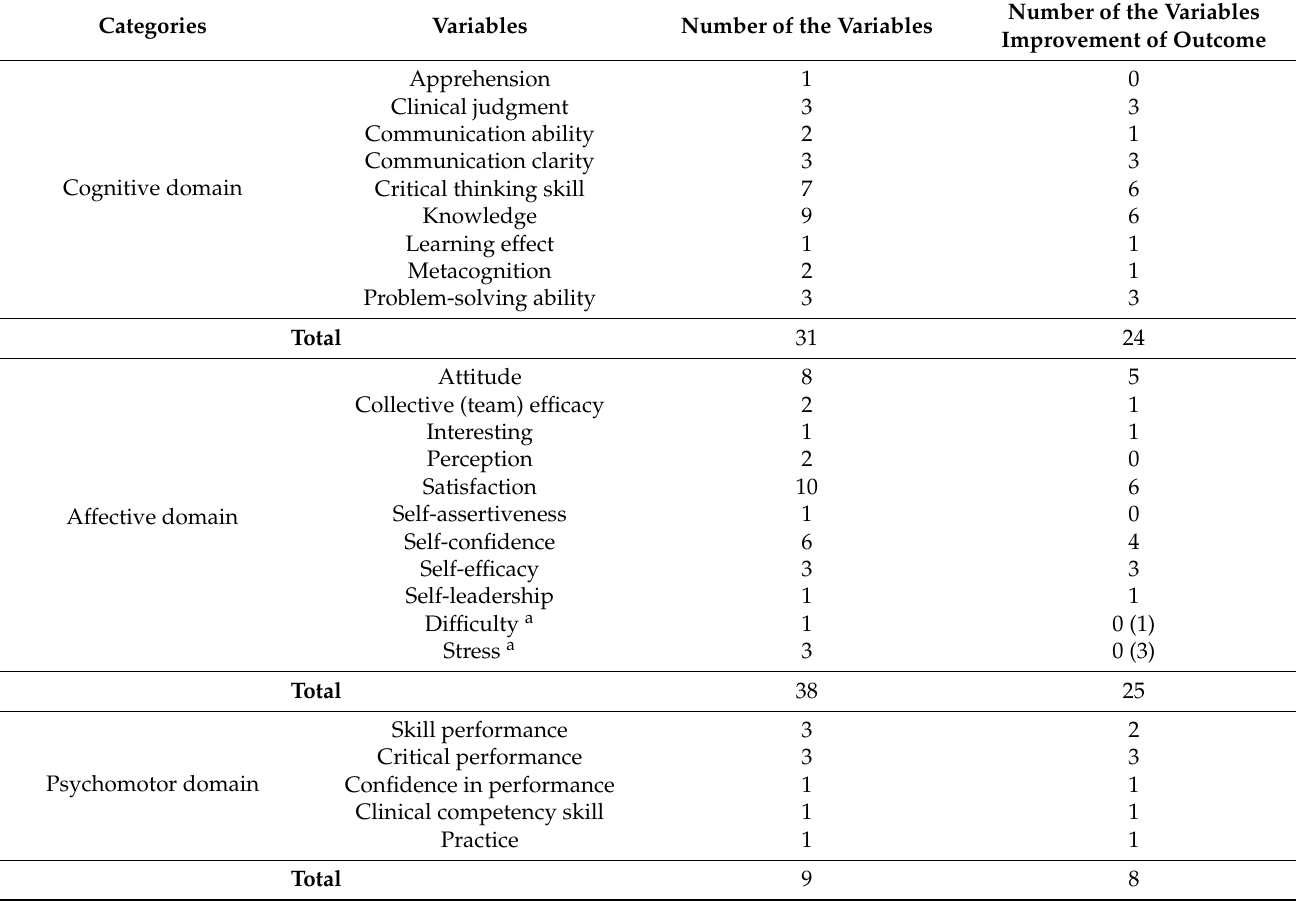
Table 5. Measurement variables and results of simulation-based education research ( n =